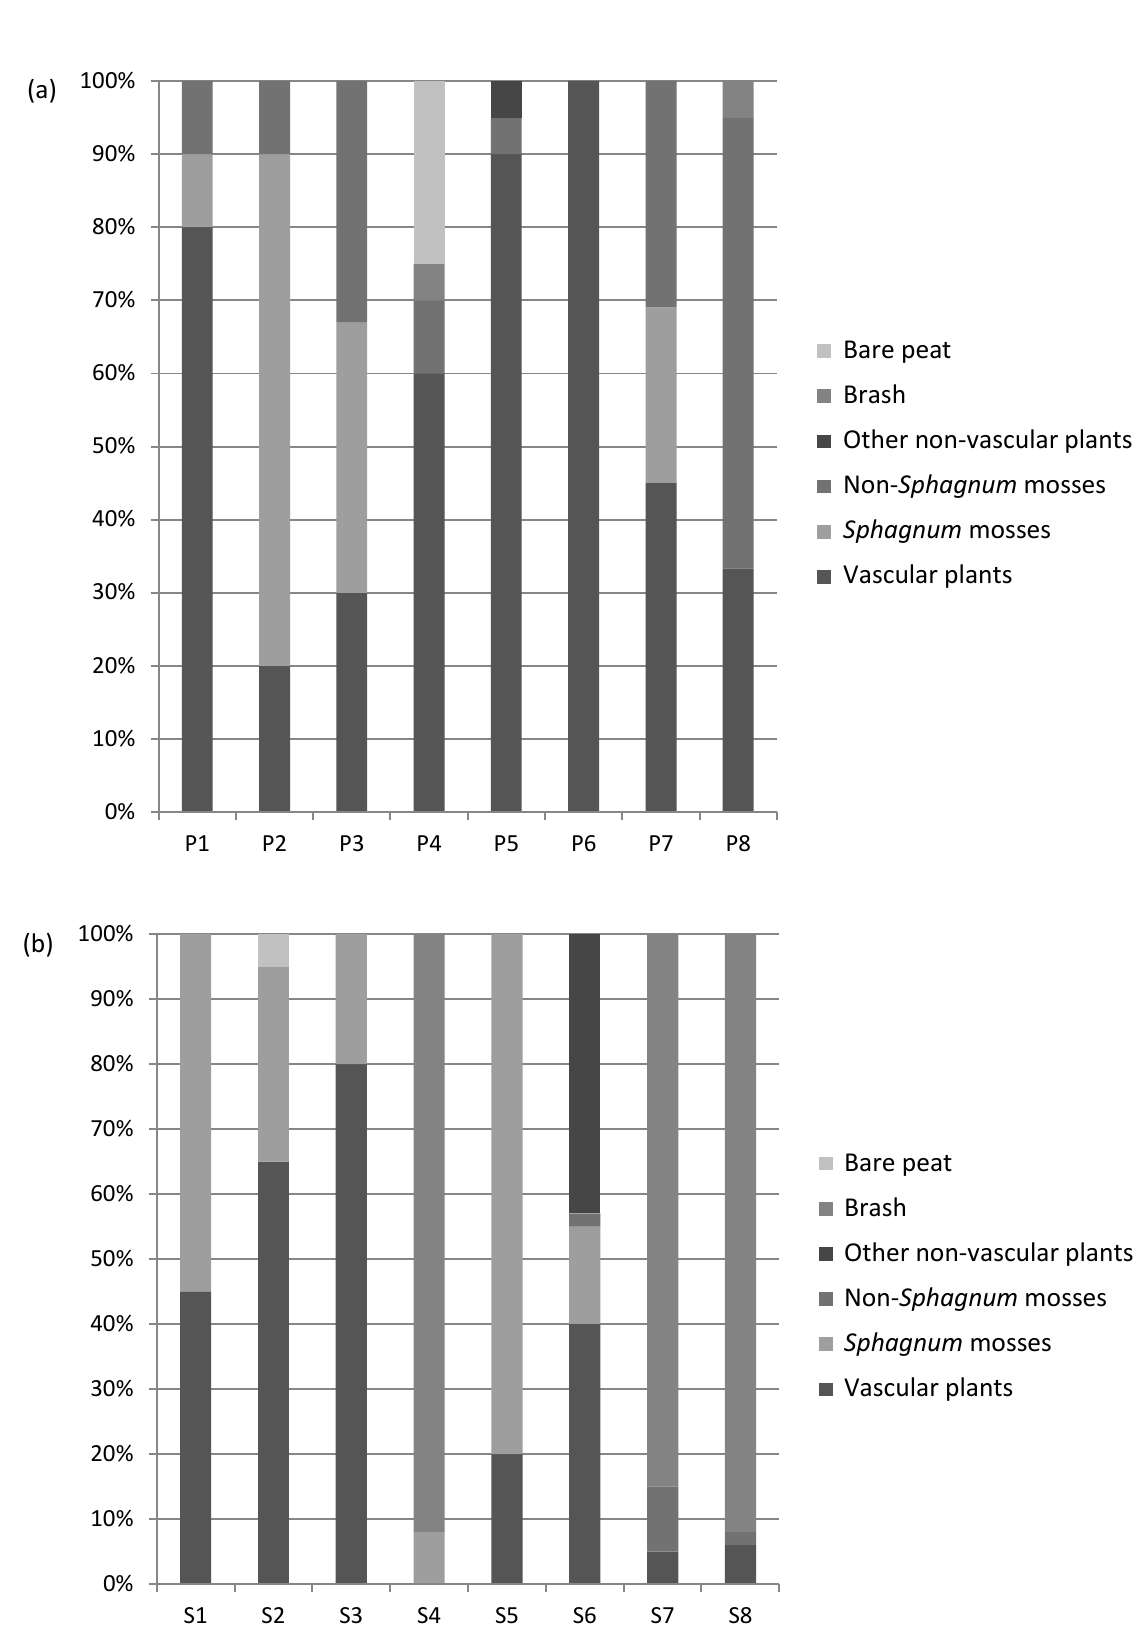
Figure A1. Percentage of each of six cover types on Plots 1–8 at (a) Pollagoona and (b)